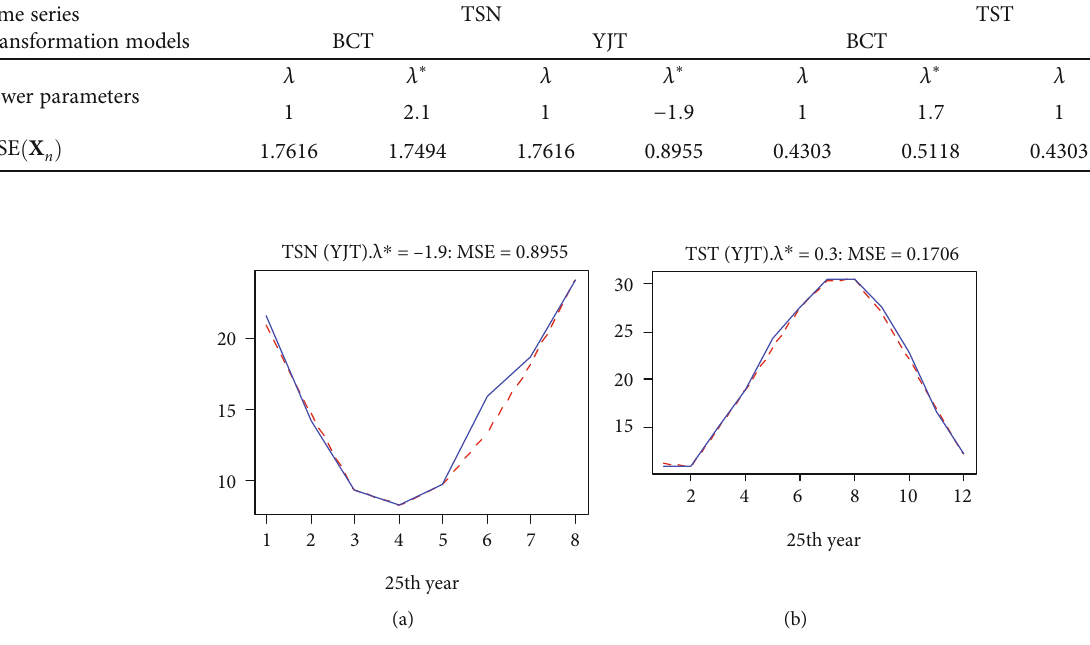
Figure 3: The plots of the original (blue) and predicted values (red) for the latest curve (25th year) of the inverse of the data transformed by the YJT model for the two time series: (a) TSN; (b)